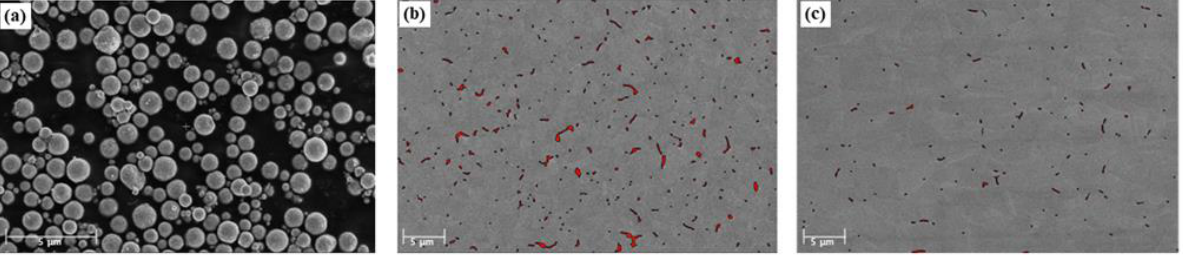
Figure 1. ( a ) Cu powder consisting of ~1.3 mm with 99.9% purity. SEM micrographs for ( b ) FGM and ( c ) FGH with ultrafine pores indicated in red.